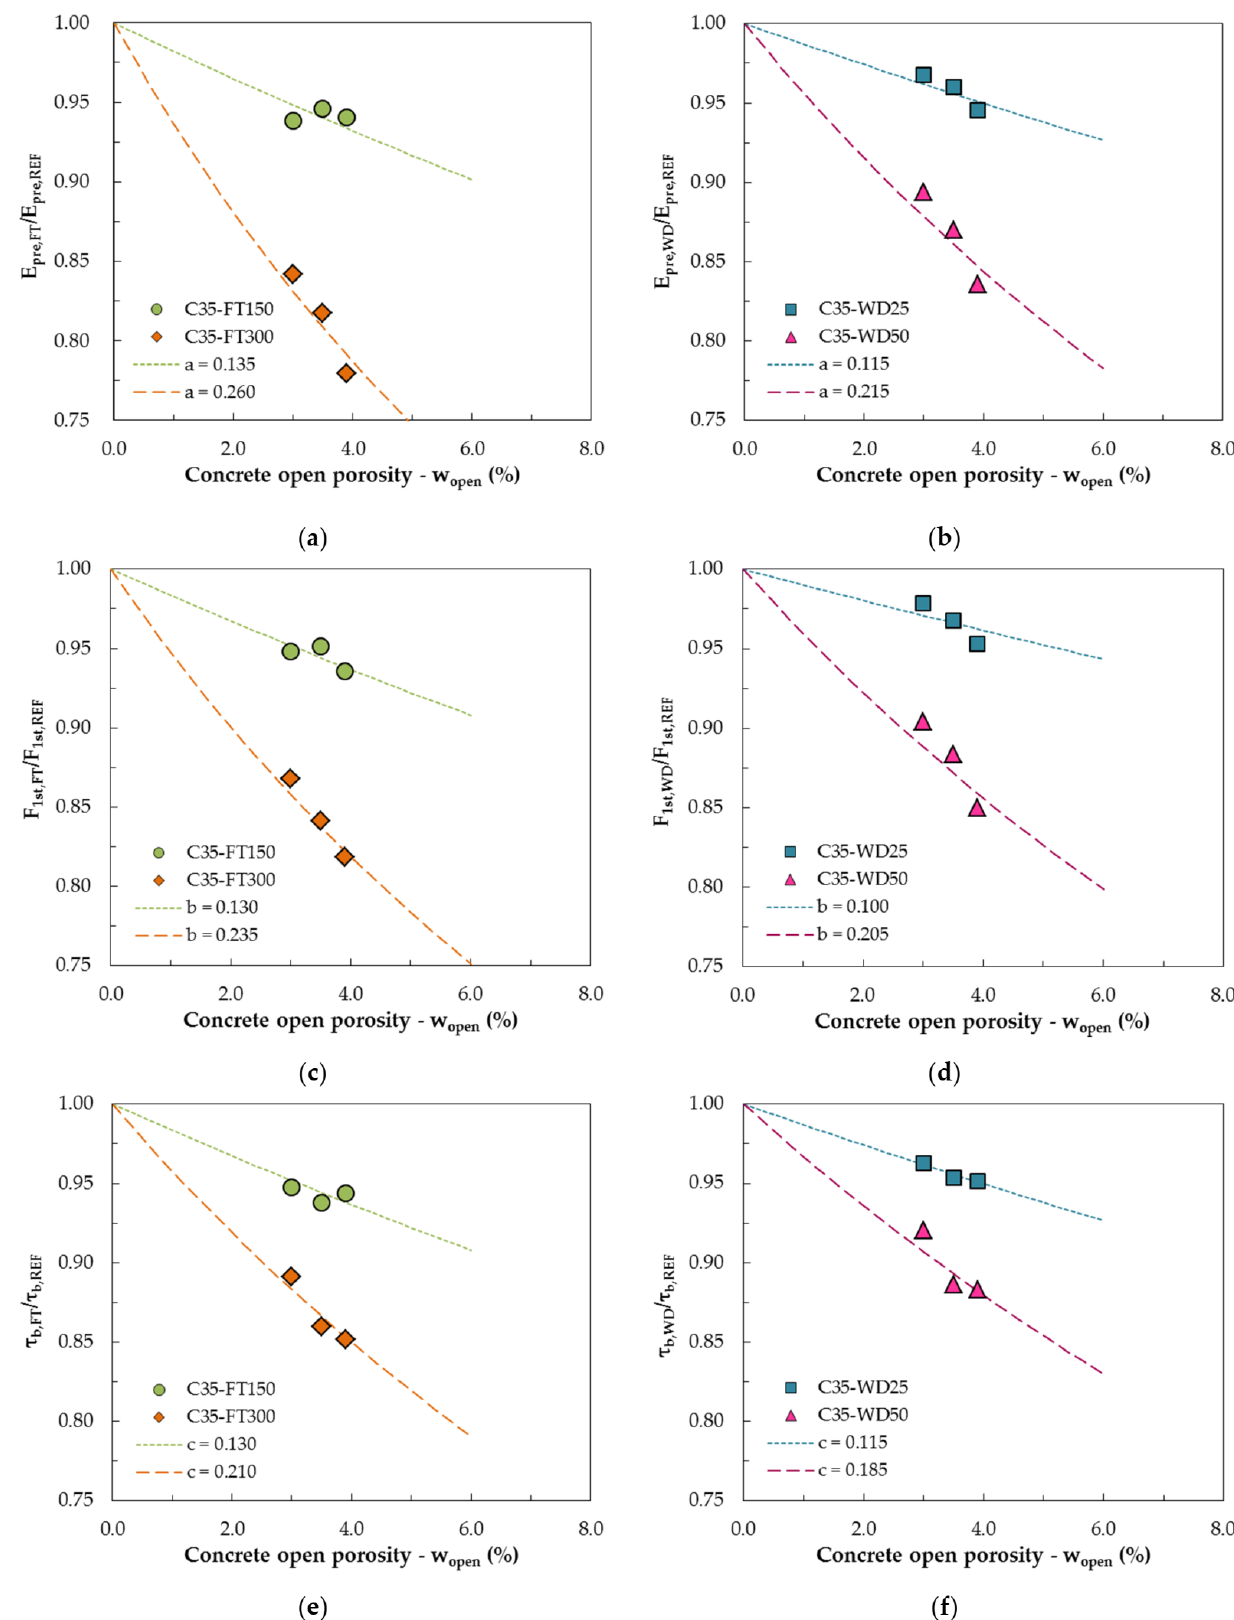
Figure 6. Relation between concrete open porosity and structural properties in the freeze-thaw and wet-dry durability studies: ( a , b ) Pre-cracking elastic modulus; ( c , d ) First crack load; ( e , f ) Bond